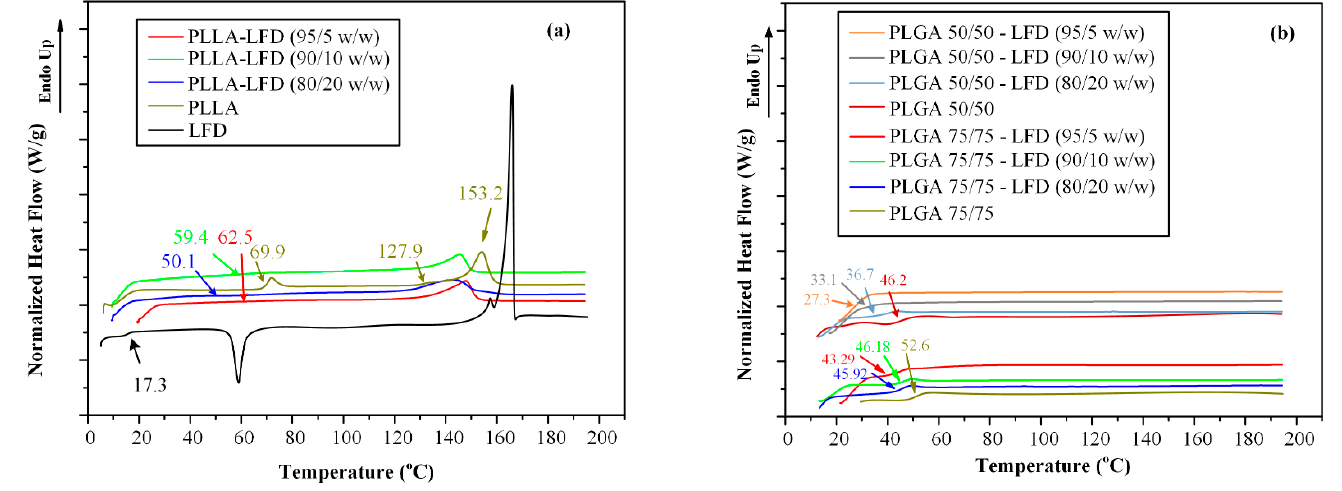
Figure 7. DSC thermograms of LDF-loaded PLLA ( a ) and LFD PLGA ( b ) thin-film patches after second heating scan.